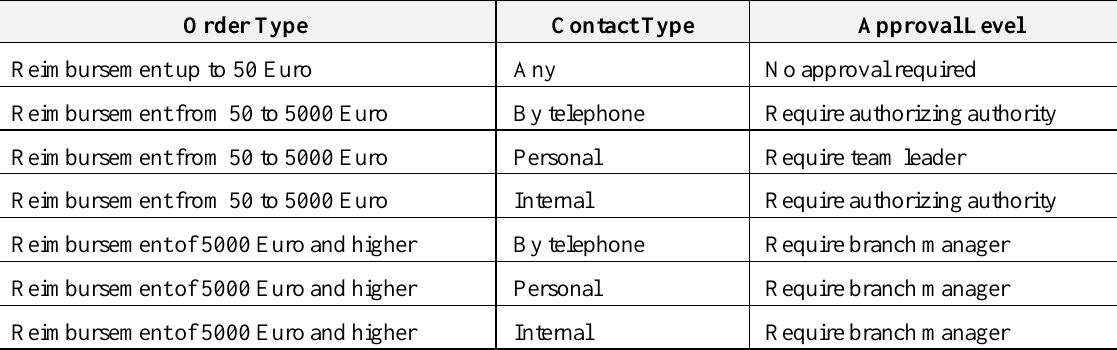
Table 3. Approval level selection rule